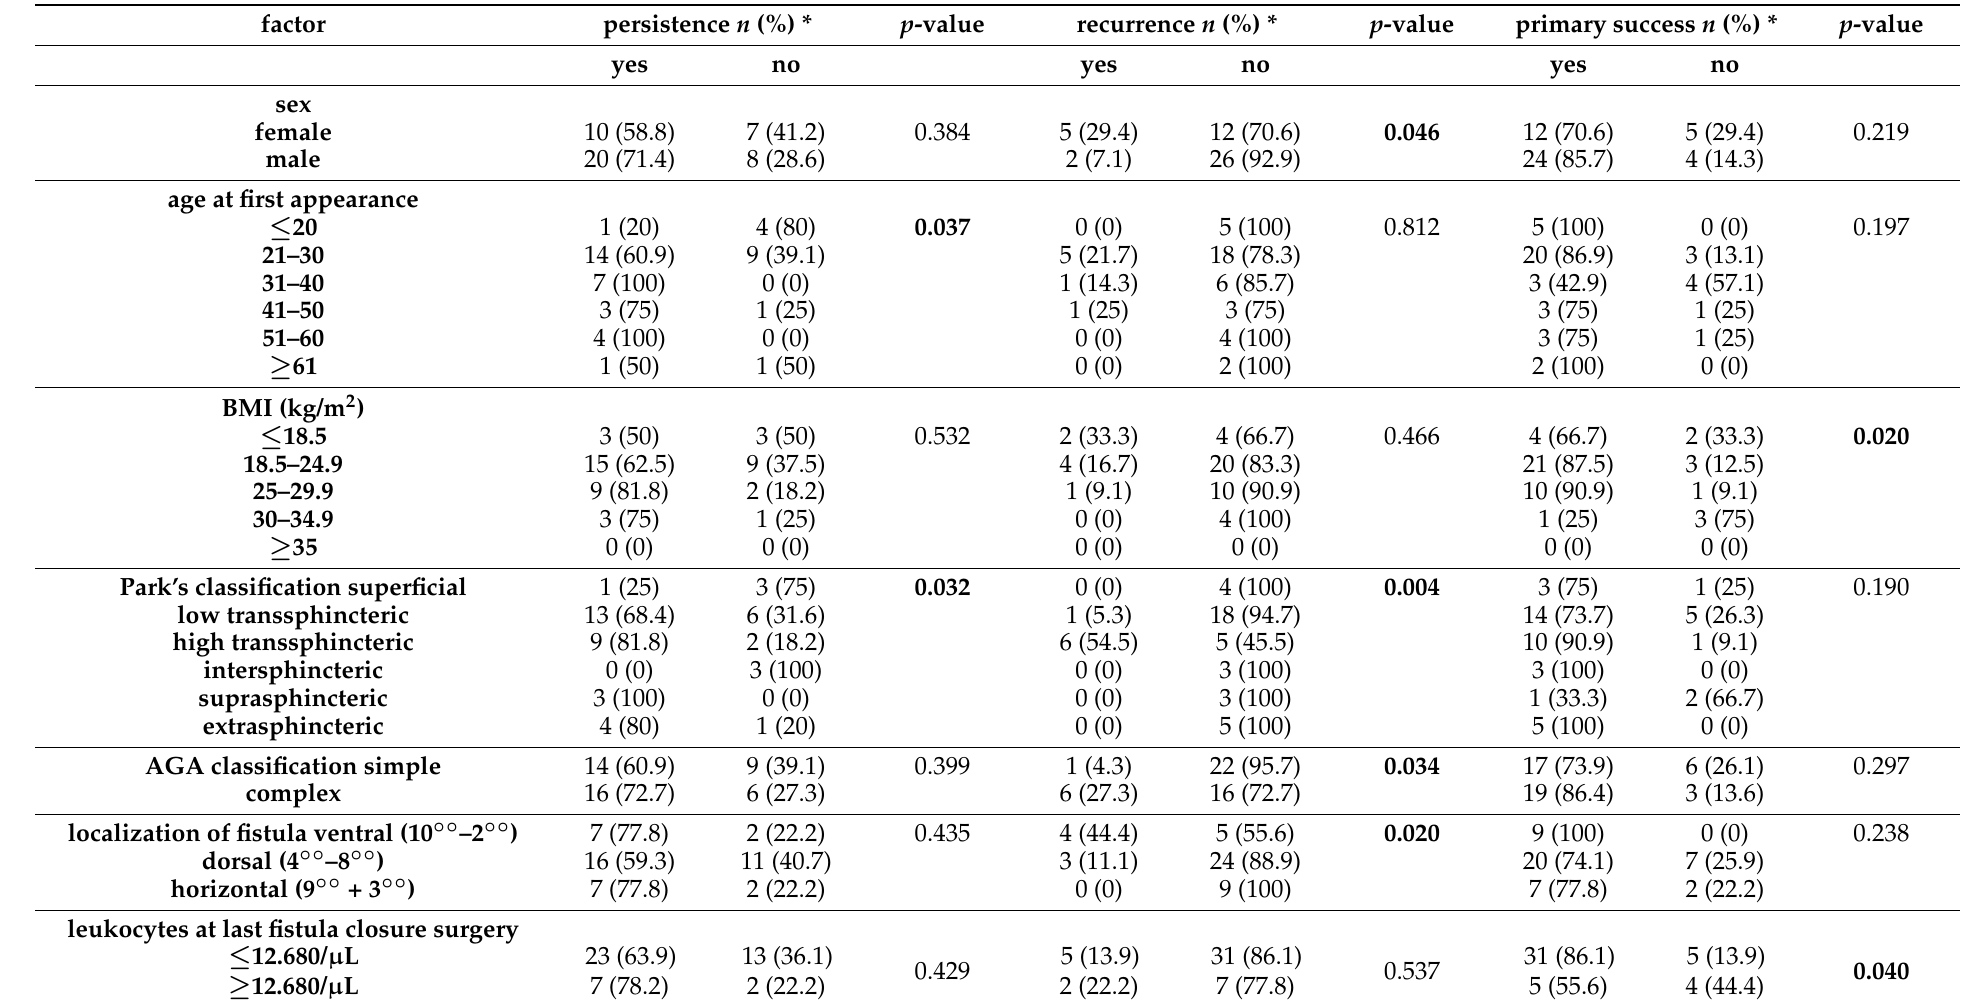
Table 6. Significant factors in univariate